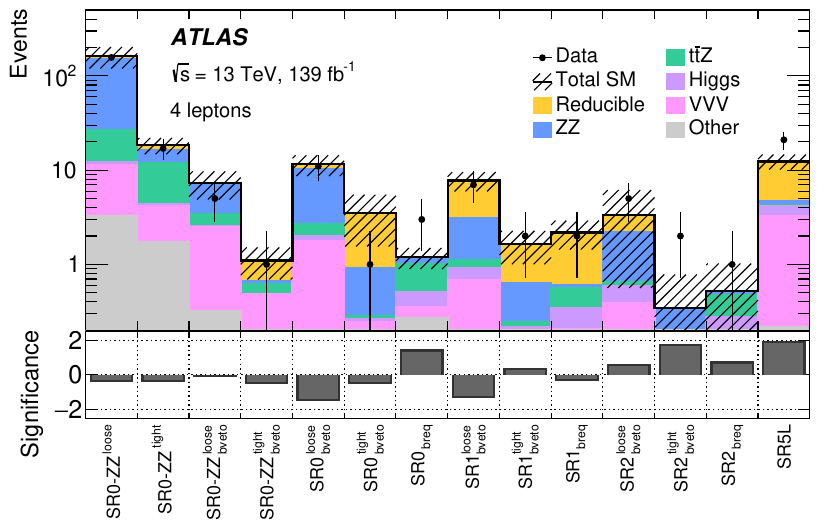
Figure 7. Expected and observed yields in the signal regions after the background-only fit. “Other” is the sum of the tWZ , t ¯ tWW , t ¯ tZZ , t ¯ tWZ , t ¯ tWH , t ¯ tHH , t ¯ ttW , and t ¯ tt ¯ t backgrounds. Both the statistical and systematic uncertainties in the SM background are included in the uncertainties shown. The significance of any difference between observed and expected yields is shown in the bottom panel, calculated with the profile likelihood method from ref.